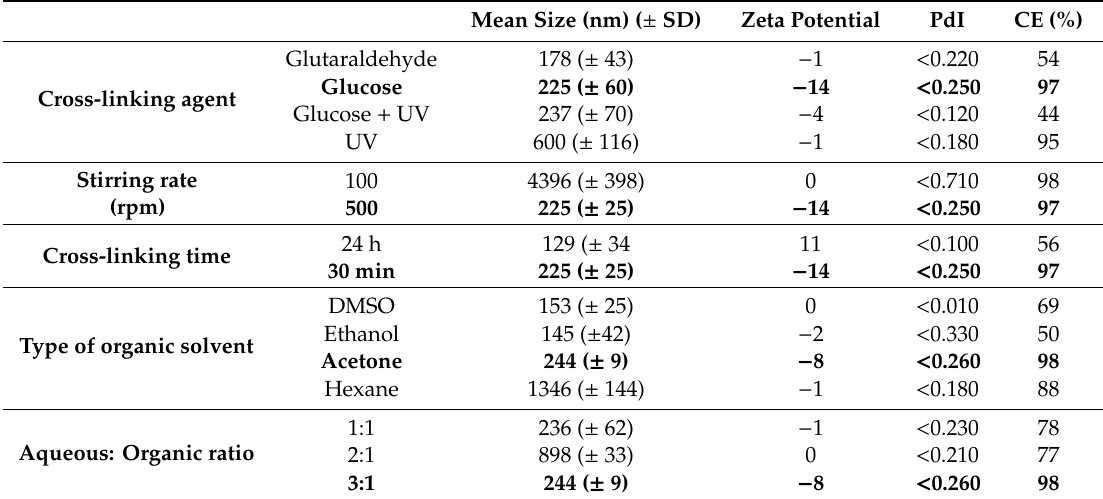
Table 1. BSA nanoparticle (NP) characterization in terms of size, zeta potential, polydispersity index (PdI) and cross-linking e ffi cacy (CE (%))—influence of experimental conditions. Mean Size (nm) ( ± SD) Zeta Potential PdI CE (%) Glutaraldehyde 178 ( ± 43) − 1 < 0.220 Glucose 225 ( ± 60) Cross-linking agent